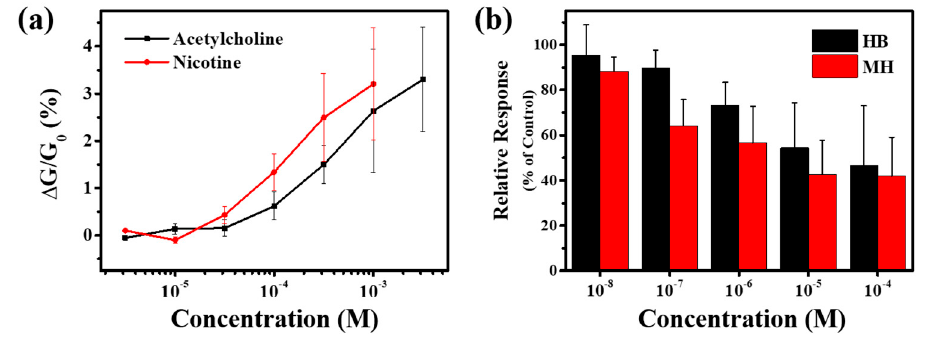
Figure 5. Quantitative monitoring of the effect of agonists and antagonists. ( a ) Conductance change with applied solutions stimulated by acetylcholine (black) and nicotine (red) at various concentrations. ( b ) Relative responses of solutions stimulated with hexamethonium (HB, black) and mecamylamine (MH, red). The inhibition effects of the drugs were observed. Data are expressed as means ± S.E.M. ( n = 3).